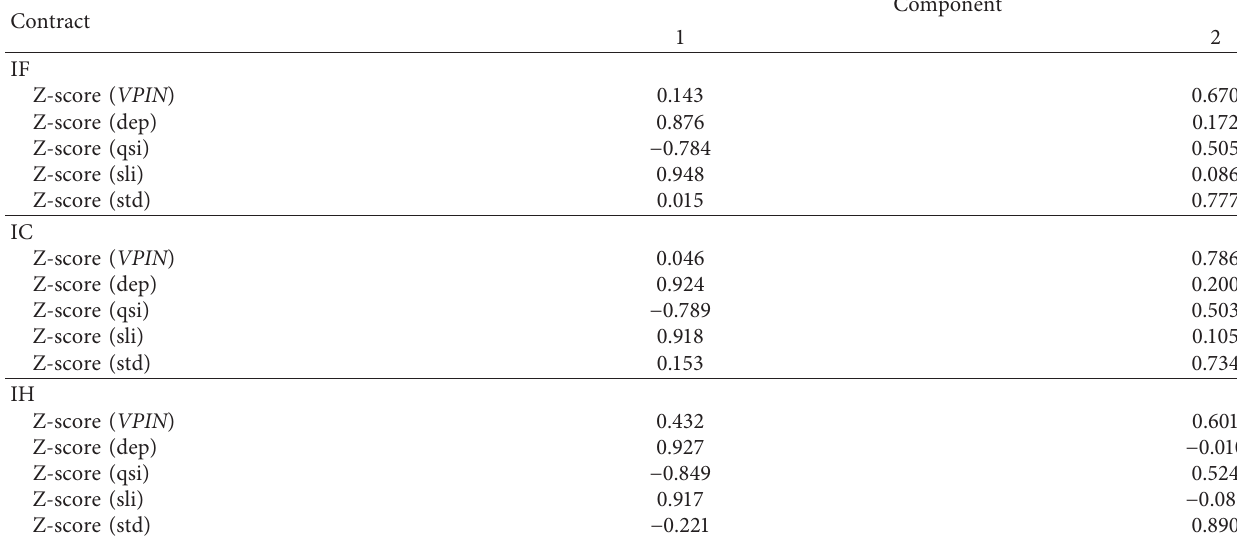
Table 11: Rotation component